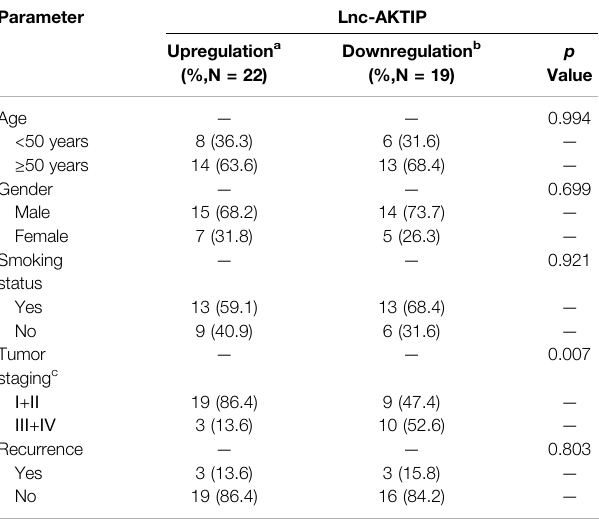
TABLE 5 | Relationships between clinical characteristics and lnc-AKTIP expression in patients with SNIP.